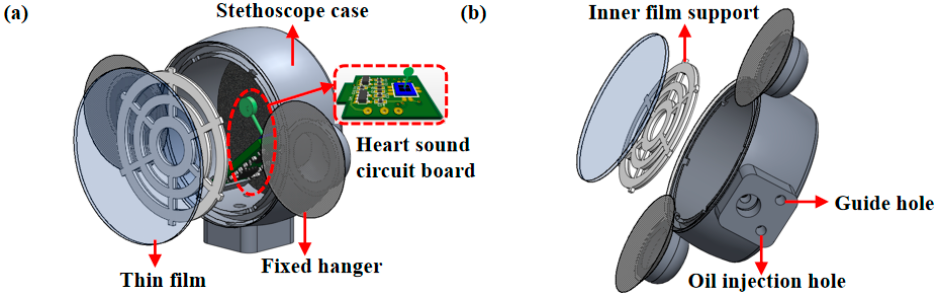
Figure 7. ( a ) Design of MEMS cardiac sound sensor probe. ( b ) MEMS cardiac sound sensor probe design side